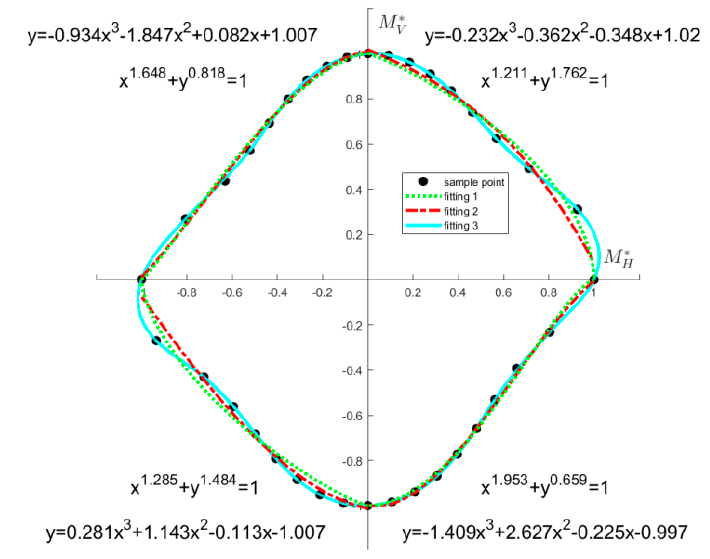
Figure 20. The case of a damaged hull due to stranding.